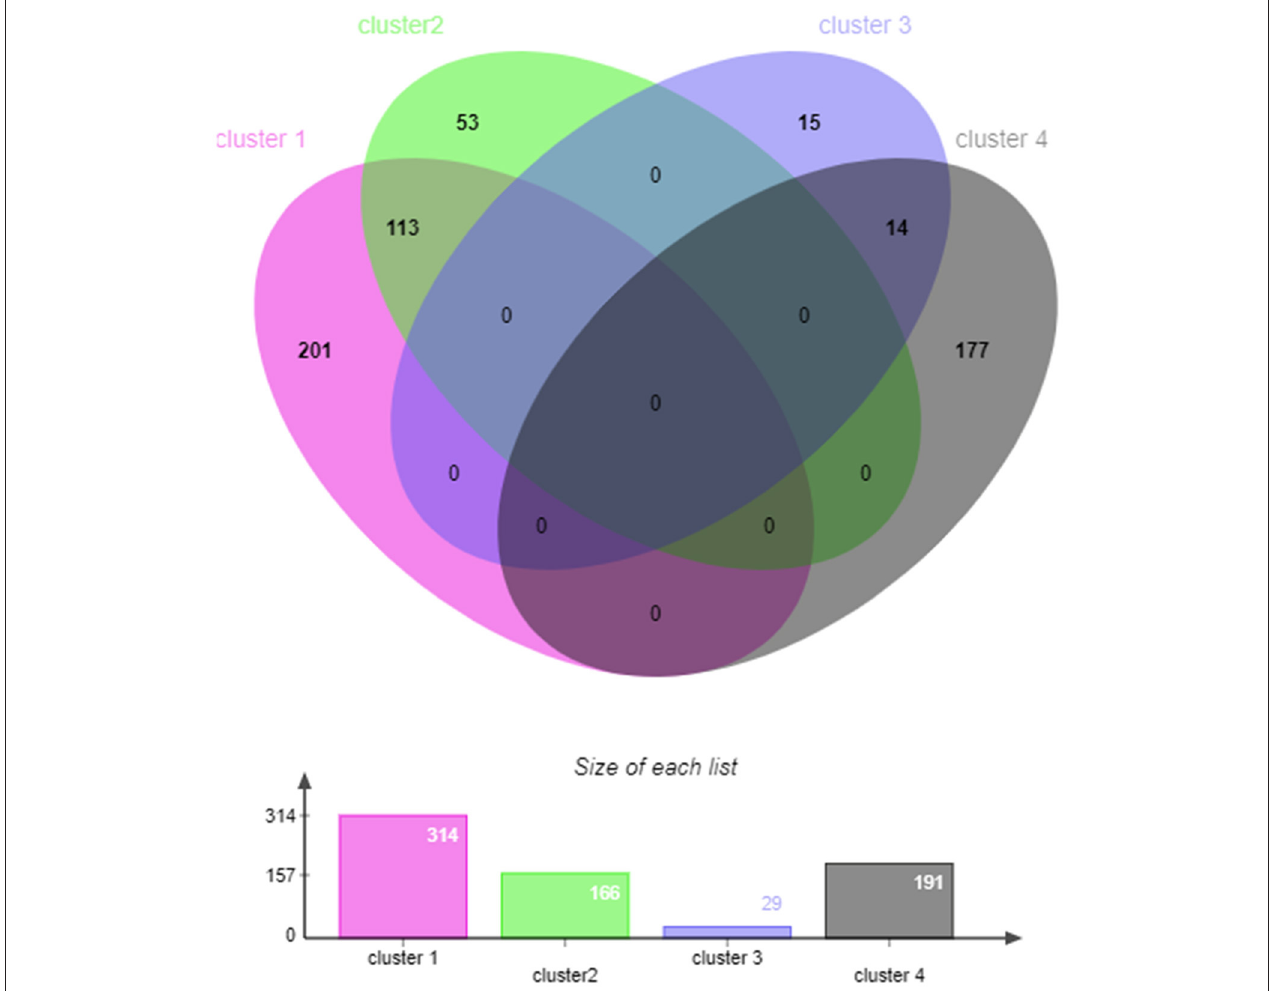
FIGURE 4 | The venn diagram of target genes that significantly enriched in the first three GO terms in cluster